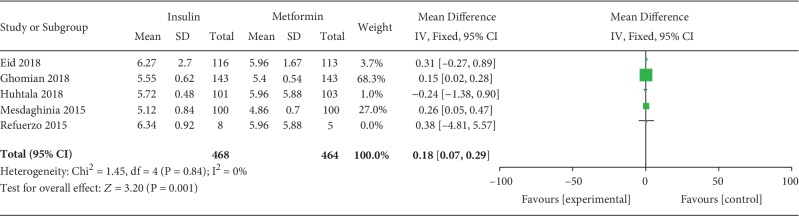
HbA1c% at delivery.